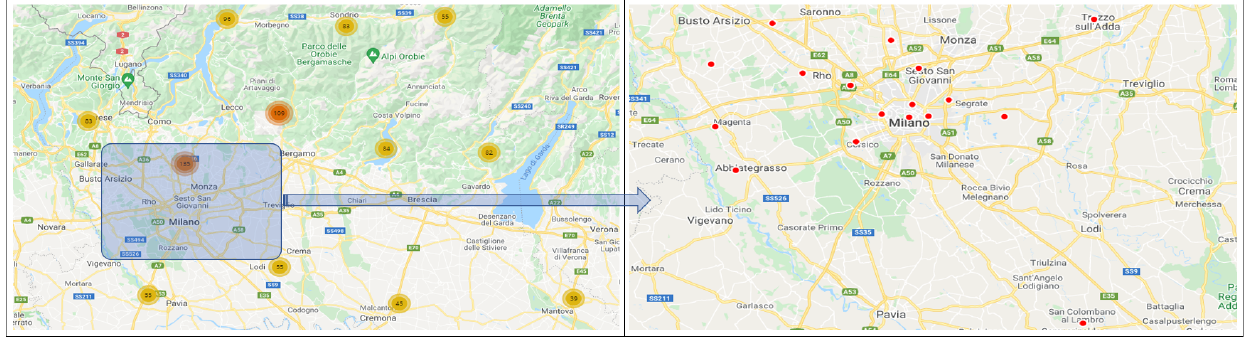
Figure 2. Locations of the 1026 active weather sensors on a regional scale ( left-hand side ) and of the 23 weather ( rain precipitation and solar radiation ) sensors located in 17 stations (red-dots) in the province of Milan ( right-hand side